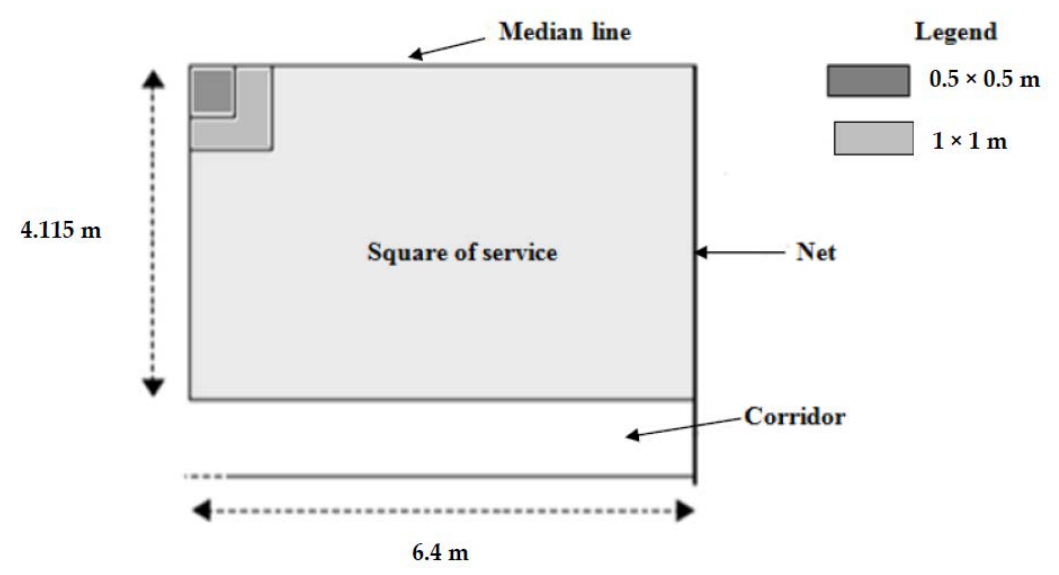
Figure 2. Service Performance Test (court